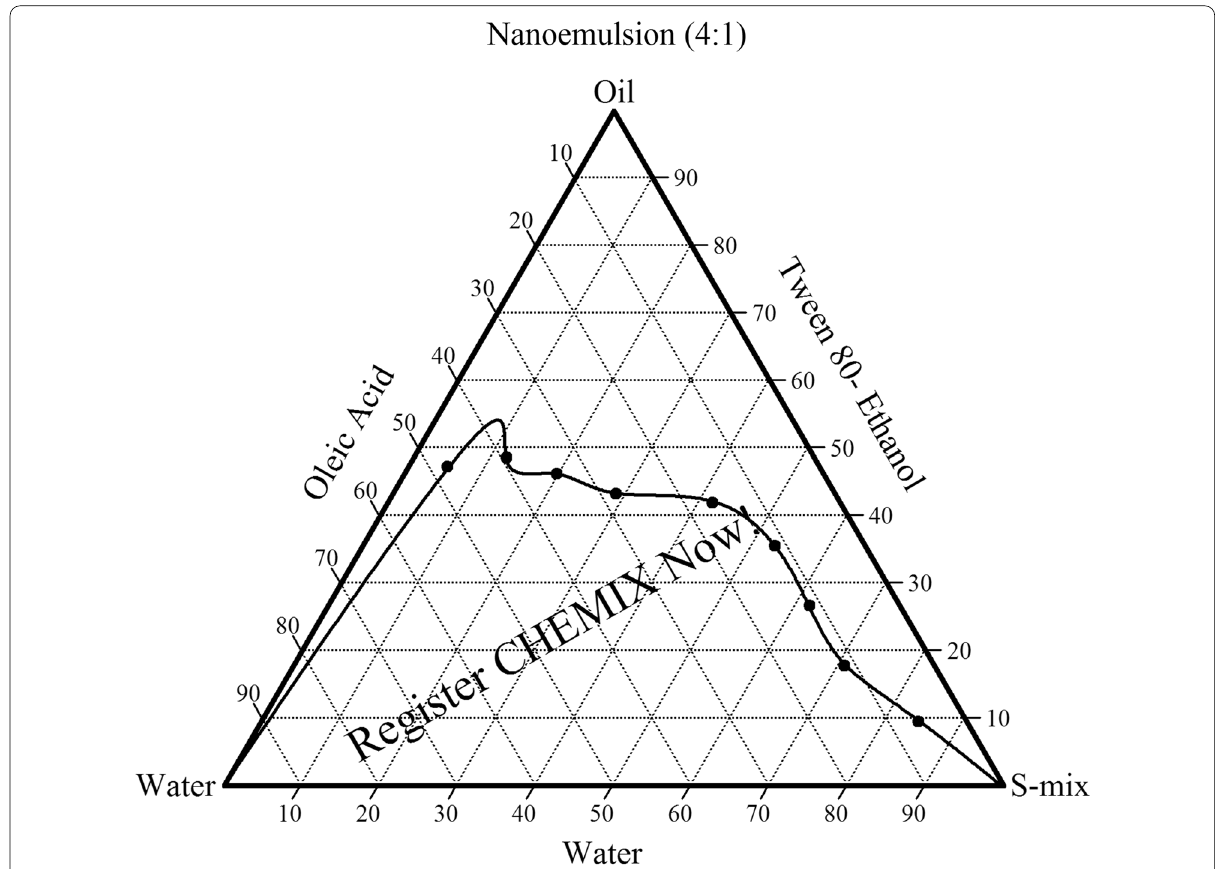
Fig. 2 Ternary phase diagram studies for ratio